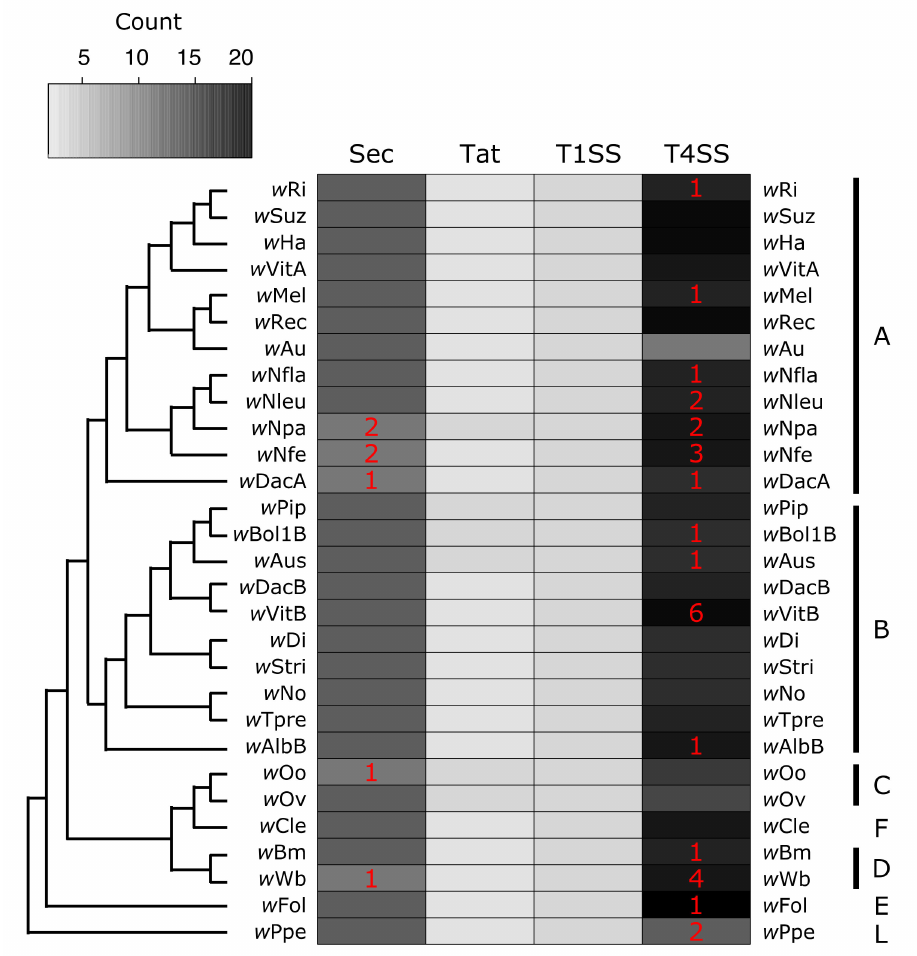
Figure 3. Presence of secretion systems across the Wolbachia phylogeny. Cladogram was drawn based o ff previously published Wolbachia phylogenies to show relationships between strains [132–134]. The grey to black scale indicates the number of putatively functional protein copies present within a Wolbachia strain for a given secretion system. Red numbers inside of the heatmap indicate how many additional gene copies are present but annotated as pseudogenized or partial (for example, w Ppe encodes for 12 proteins that make up a T4SS, plus an additional two pseudogenized ORFs also corresponding to T4SS proteins). Supergroup membership (monophyletic clades of Wolbachia historically used for designation) of the strains is indicated with the capital letters on the right side of the